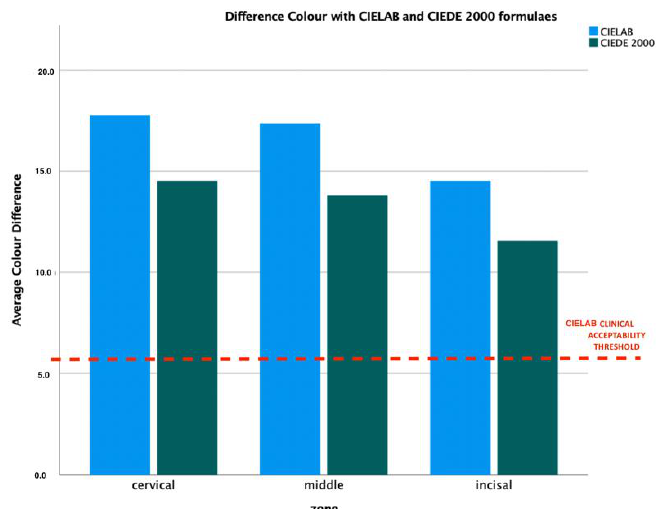
Figure 3. Colour differences (∆Eab* and ΔE00*) exceeded the threshold of clinical acceptability. With both formulas, the ANOVA with one factor of variation (thirds of the tooth) in a randomised block design (subjects) revealed that the chromatic changes in the three areas differed significantly ( p = 0.002). Subsequently, Duncan’s test showed that